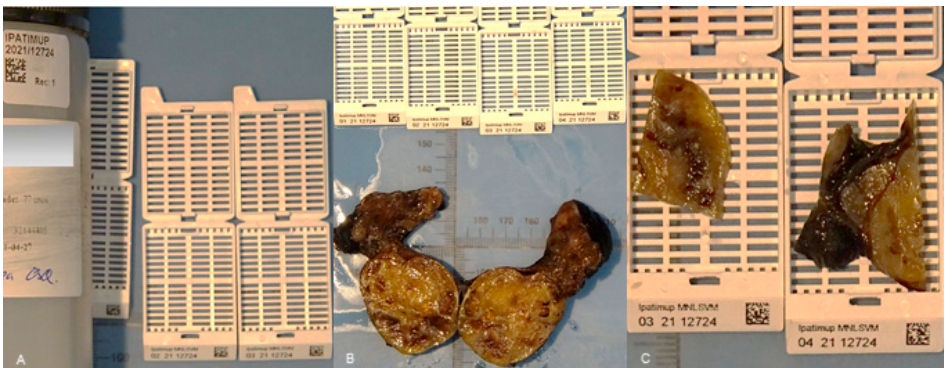
Figure 3. Containers with specimens are labeled with QR codes and photographed at arrival ( A ). Photographic documentation of the specimen is performed ( B ) as well as of the selected fragments inside the respective labeled cassettes ( C ).